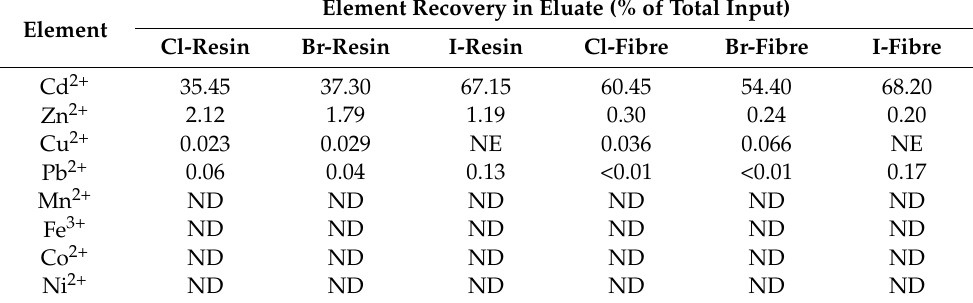
Table 5. Metal recovery by NH 3 elution. Element